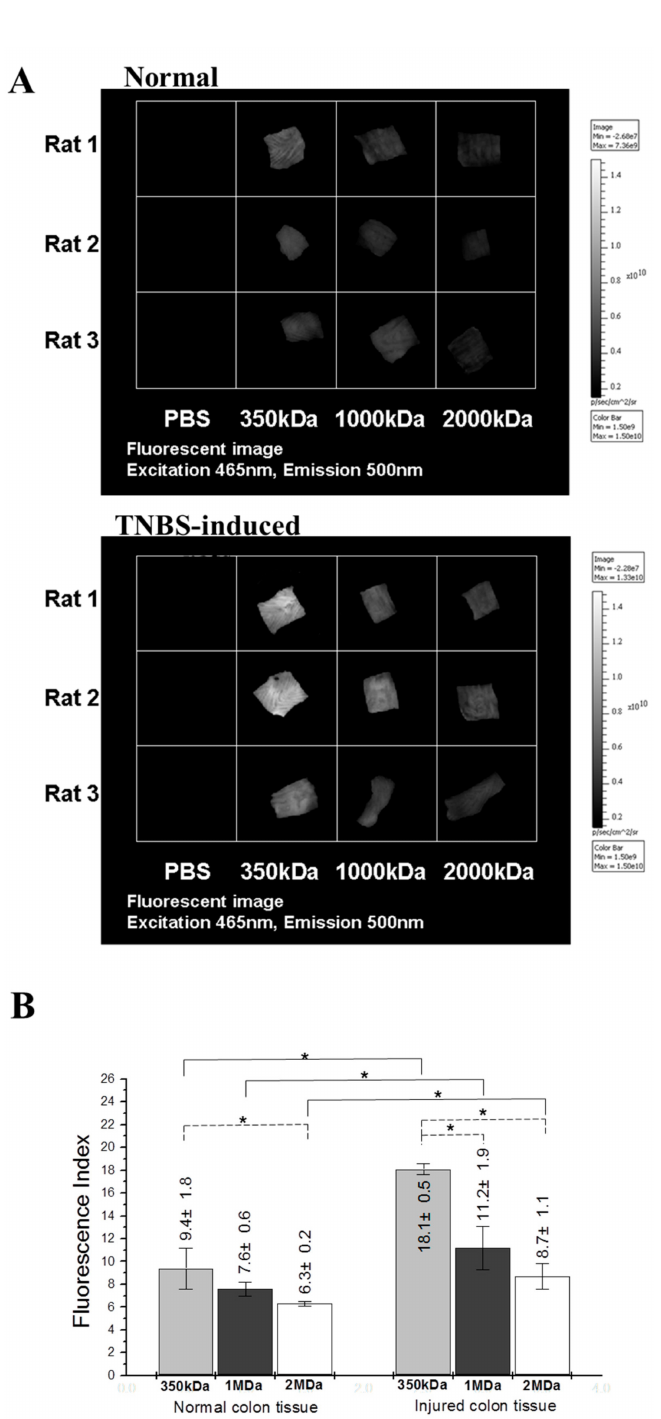
Figure 1. Adhesion observations of three FL-Labeled HA conjugates in the colon tissues of rats by using an IVIS. Three FL-Labeled HA conjugates used in the normal and injured colon tissues of rats ( A ); Three FL-Labeled HA conjugates used in the normal (upper) and injured (below) colon tissues of rats. Quantitative analysis of fluorescence intensity (%) = intensity of the tissue immersed in the sample solution/intensity of the tissue immersed in PBS solution ( B ). Data represent the mean ± SEM ( n = 6) of three independent experiments. Differences were considered significant if the p < 0.05 (*). These results demonstrate that the amount of the HA biopolymer adsorbed on the injured colon tissue was significantly higher than that on the normal colon tissue ( p < 0.05 (*); Figure 1B).